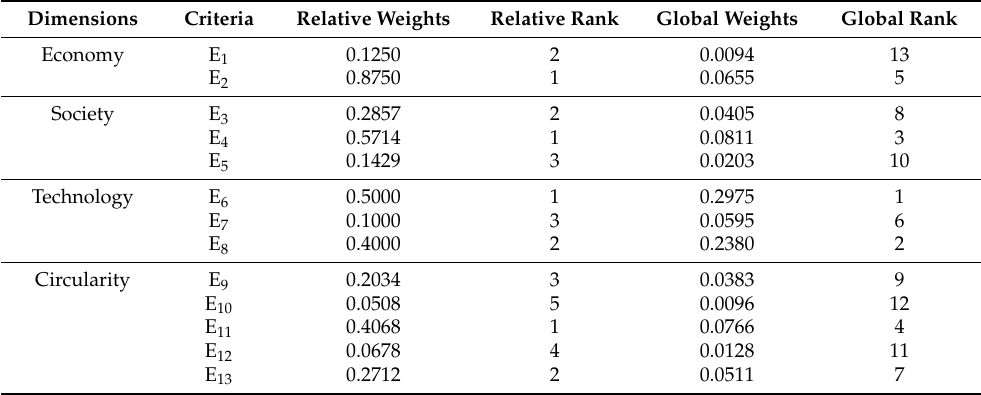
Table 5. The weights and ranking of